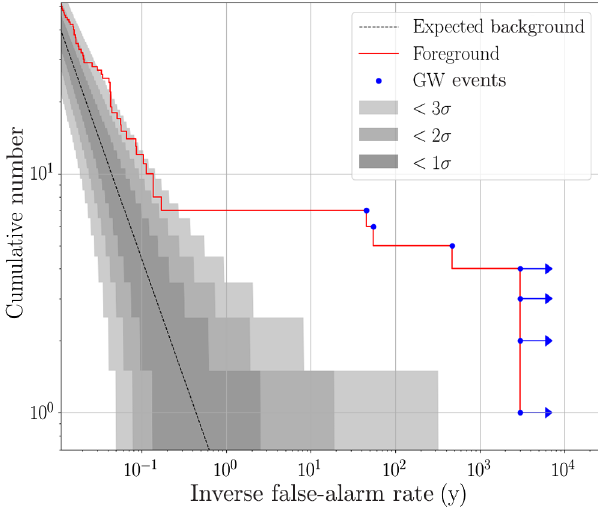
FIG. 3. Cumulative histograms of search results for the cWB search, plotted versus the inverse false-alarm rate. The dashed lines show the expected background, given the analysis time. Shaded regions denote sigma uncertainty bounds for Poisson uncertainty. The blue dots are the named gravitational-wave events found by each respective search. Any events with a measured or bounded inverse false-alarm rate greater than 3000 y are shown with an arrow pointing